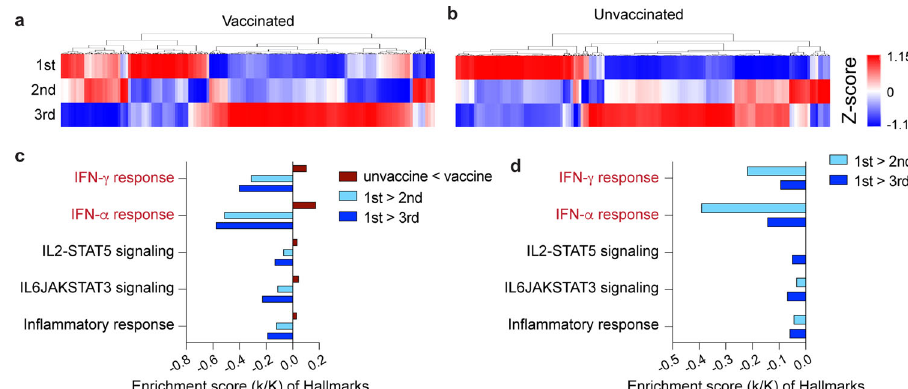
Fig. 4 Longitudinal transcriptome study. a , b Heatmap shows the expression levels of 522 genes signi fi cantly regulated in vaccinated ( a ) and unvaccinated ( b ) patients throughout the 6-week longitudinal study (analysis of samples from the three time windows). Each sample is hierarchically clustered by using their adjacency scores as distance. c , d Genes reduced signi fi cantly in the longitudinal analysis of vaccinated ( c ) and unvaccinated ( d ) were signi fi cantly enriched in Hallmark Gene Sets (FDR q value < 0.005). All hallmarks are related to immune regulation.